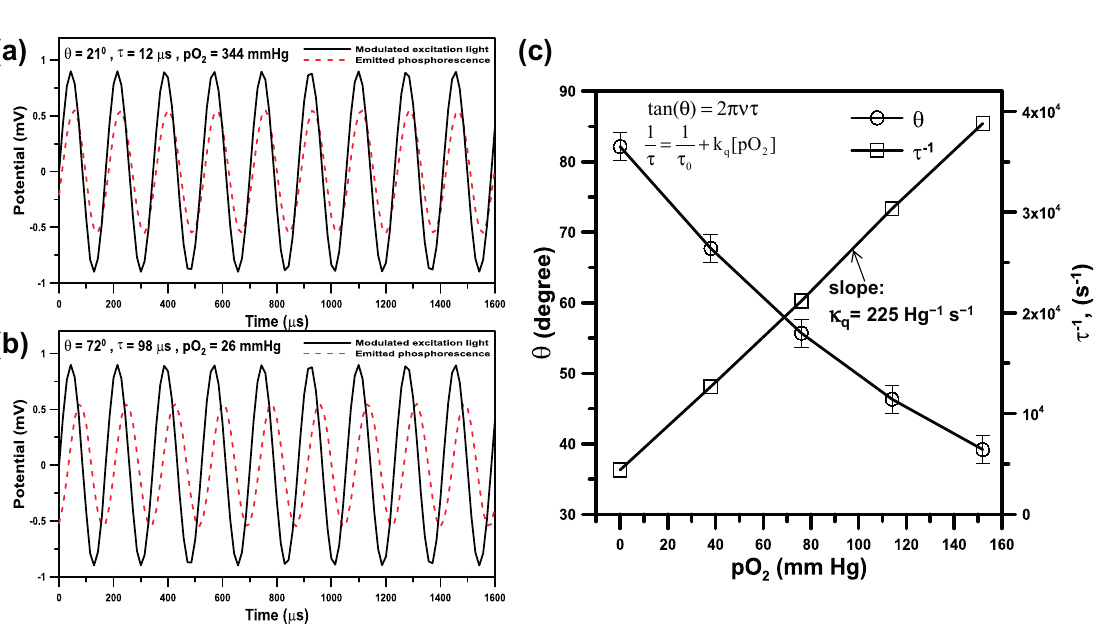
Figure 6. The typical time domain of the reference signal (modulated excitation light) and the corresponding phosphorescent detection signal for oxygen measurements at ( a ) pO 2 = 344 mmHg and ( b ) pO 2 = 26 mmHg, respectively; ( c ) Calibration on the phase shift ( θ ), a reciprocal of the luminescent lifetime ( τ ) with respective to the oxygen pressure [pO 2